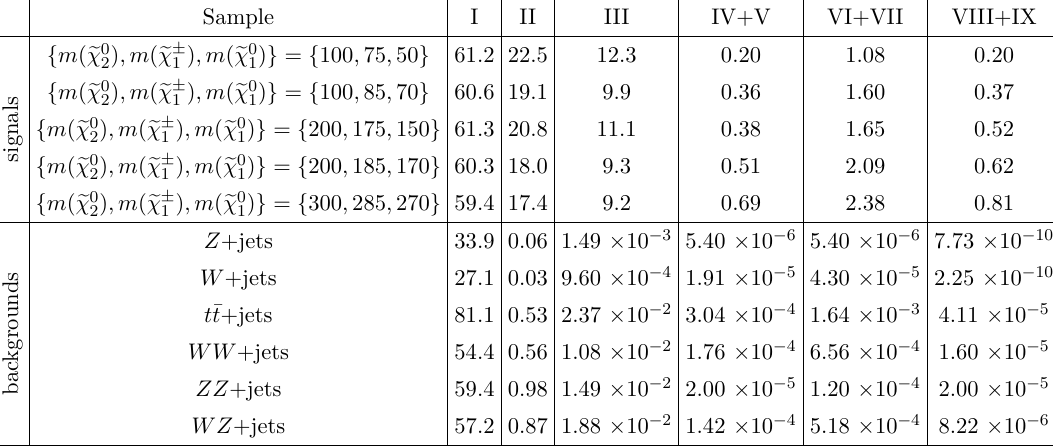
Table 4 . Cumulative efficiencies for some signal and backgrounds samples, expressed as percentages. The Roman numbers are associated to the segments of events selections presented in table